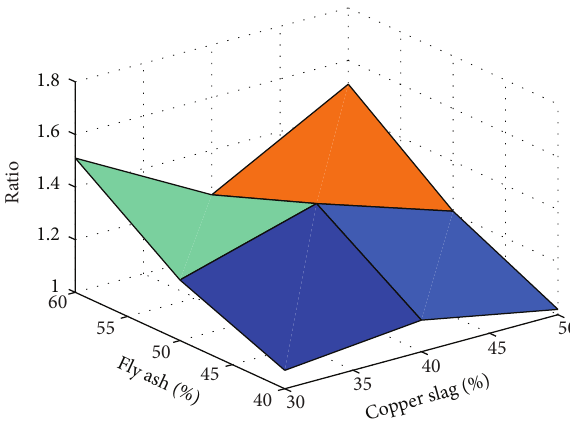
Figure 15: Results of experiment with polypropylene fibres.